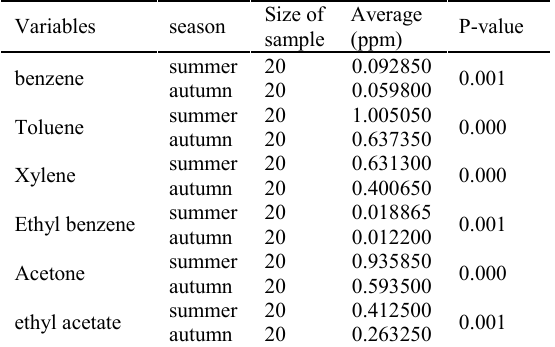
Table 3. Effect of season on the concentration of volatile organic